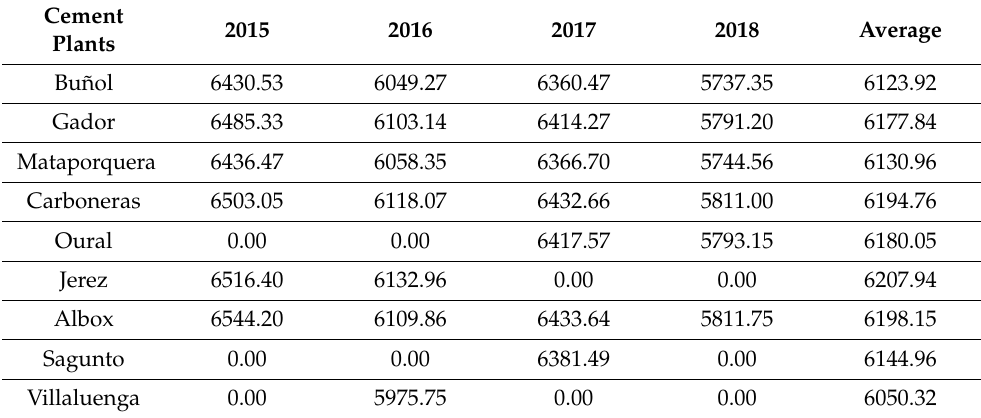
Table 9. Consumed energy for the waste-to-fuel case (kWh/t waste